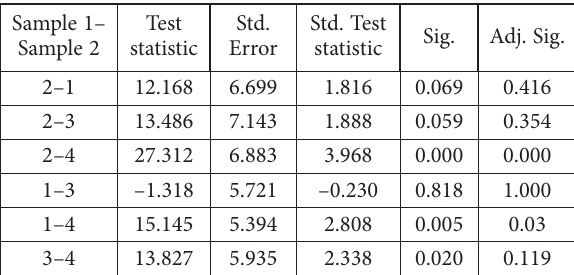
Table 10. Pairwise cluster comparison using Dunn–Bonferroni